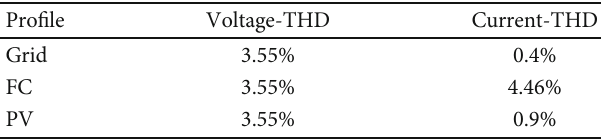
Figure 39: THD values for microgrid voltage load. Table 4: THD comparative values for grid, fuel cell, and